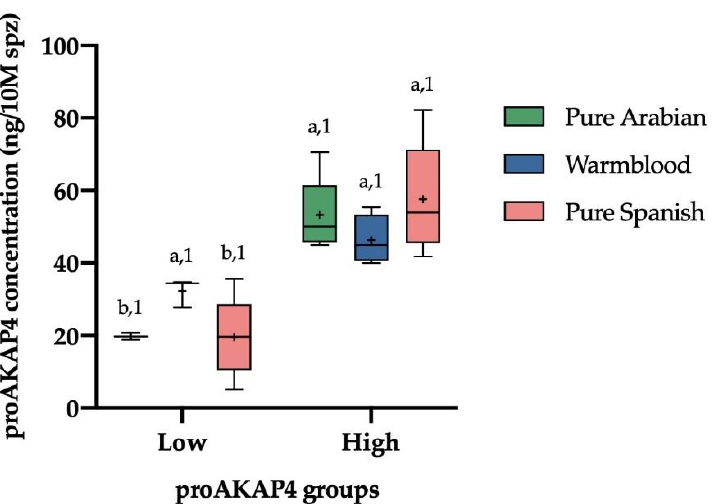
Figure 2. Box–whisker plot showing the differences in proAKAP4 concentration (ng/10M spz) of frozen–thawed horse ejaculates from different breeds (Pure Arabian breed = red; Warmblood breed = blue; pure Spanish breed = green) as having low or high proAKAP4 concentration (ng/10M spz). The line indicates the median, the cross indicates the mean, the boxes enclose the 25th and 75th percentiles, and the whiskers extend to the 5th and 95th percentiles. (a,b) Different letters indicate significant difference ( p ≤ 0.05) between the proAKAP4 groups within each breed. The same number indicates no significant difference ( p > 0.05) between breeds within each proAKAP4 group.